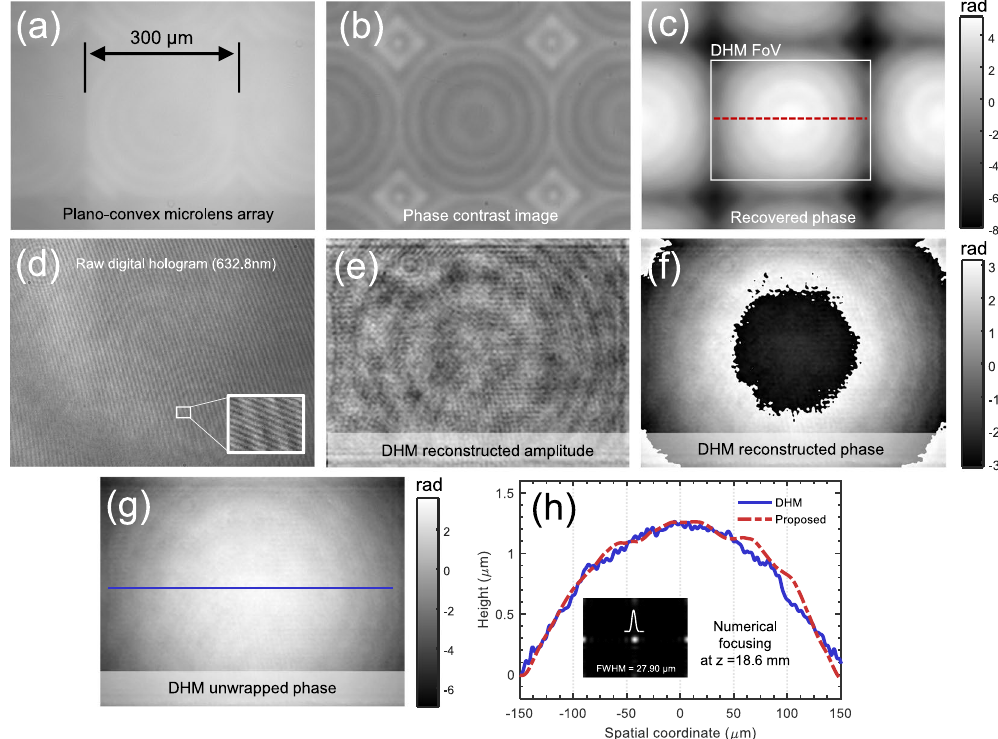
Figure 13. Microlens array characterization using AI-TIE. ( a ) In-focus intensity image. ( b ) Phase contrast microscope image. ( c ) Reconstructed phase image by AI-TIE. ( d ) Digital hologram captured by a DHM system. The carrier fringes can be easily seen in the magnified area. ( e ) DHM reconstructed amplitude. ( f ) DHM reconstructed (wrapped) phase. ( g ) Unwrapped phase. ( h ) Height line profiles corresponding to the red dashed line in ( c ) and the blue solid line in ( g ),